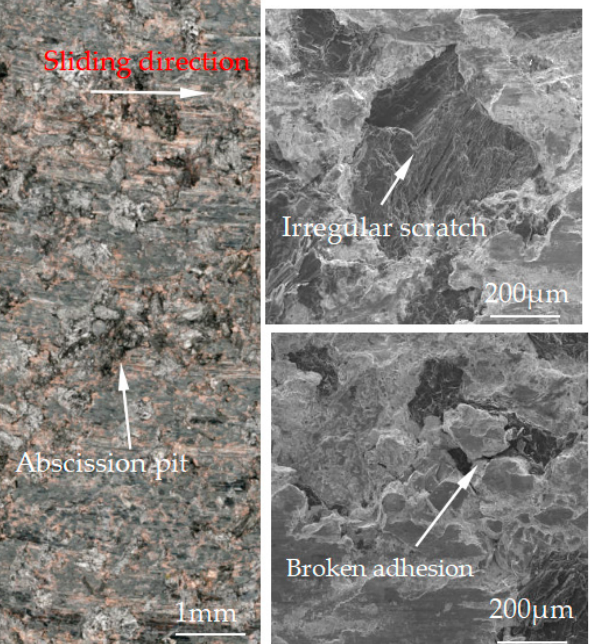
Figure 7. Surface morphology of the pad material after intermittent braking at an ambient temperature of 20 °C.